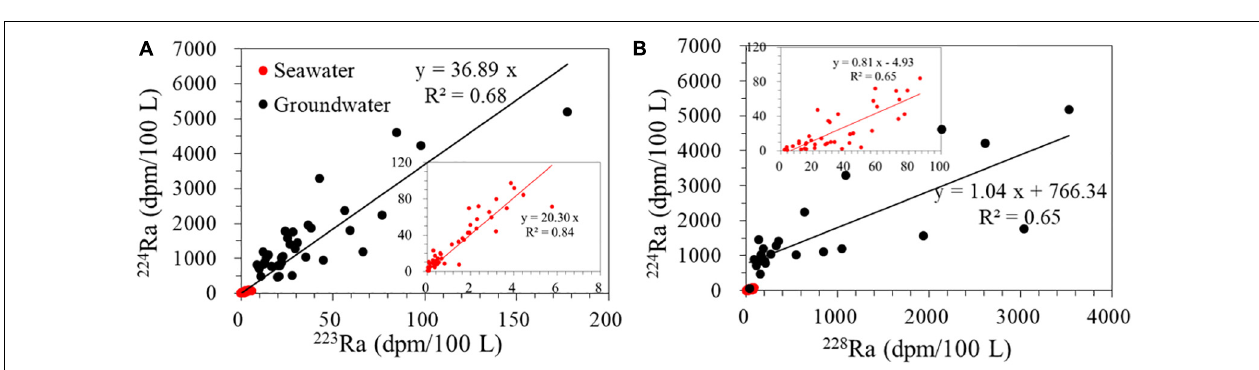
FIGURE 3 | Plots of panel (A) 224 Ra vs. 223 Ra, and (B) 224 Ra vs. 228 Ra in seawater and coastal groundwater samples of the